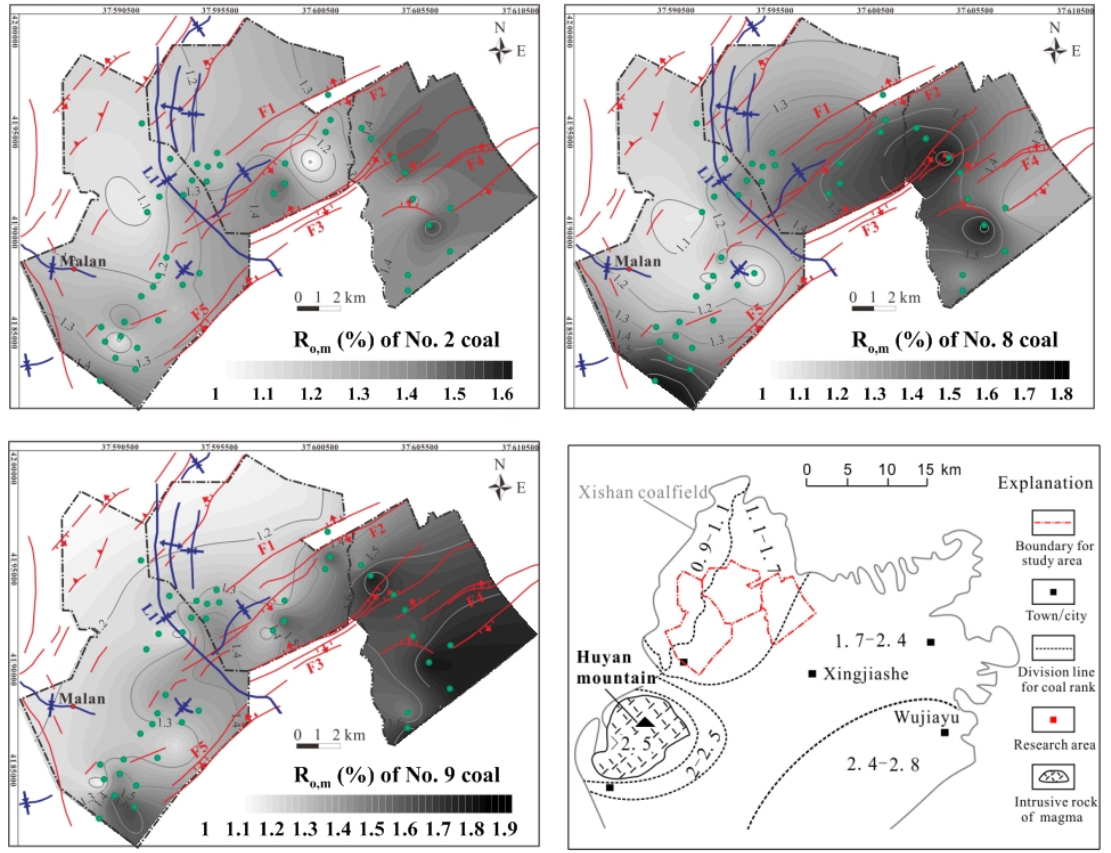
Figure 9. Maximum vitrinite reflectance (R o,m ) of Nos. 2, 8, and 9 coals in the Gujiao area and the maximum vitrinite reflectance of the circumjacent Xishan coalfield [52].